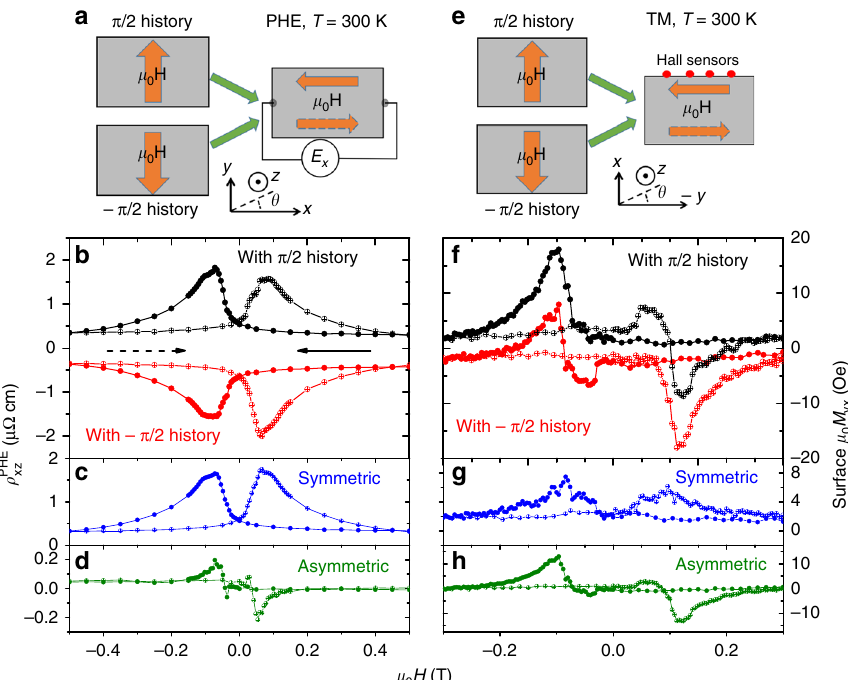
Fig. 4 Dependence of planar Hall effect and transverse magnetization on prior history. a The experimental protocol: measurements were performed in identical con fi gurations but following different prior histories. In both cases, the applied magnetic fi eld and the measured electric fi eld were both along the x -axis and the magnetic fi eld was swept from − x (that is θ = π ) to + x . Before the measurement, however, in one case the magnetic fi eld was rotated from − π /2 toward π , but in another from + π /2 toward π . b The planar Hall data for the two measurements. The prior history determines the sign of the observed signal. c The difference between the two data sets shown in ( b ) (the symmetric component). d The sum of the two data sets shown in ( b ) (the asymmetric response). e The experimental protocol for measuring transverse magnetization, similar to ( a ). f Transverse magnetization data for the two measurements. g The difference between the two measurements in ( f ) (the symmetric component). h The sum of the two measurements in ( f ) (the asymmetric component). The closed and open symbols refer to opposite fi eld sweep orientations, marked by solid and dotted arrows shown in ( b )